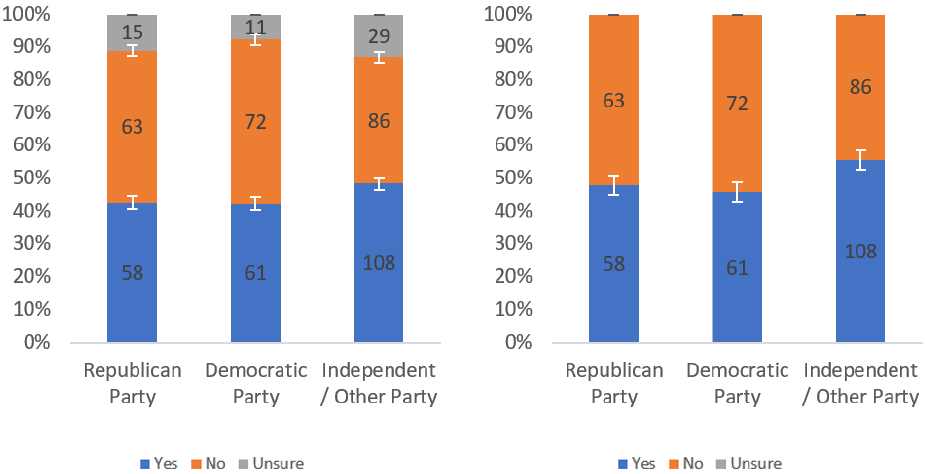
Figure A20. Responses regarding label annoyingness by party affiliation including ( left ) and exclud- ing ( right ) unsure responses.